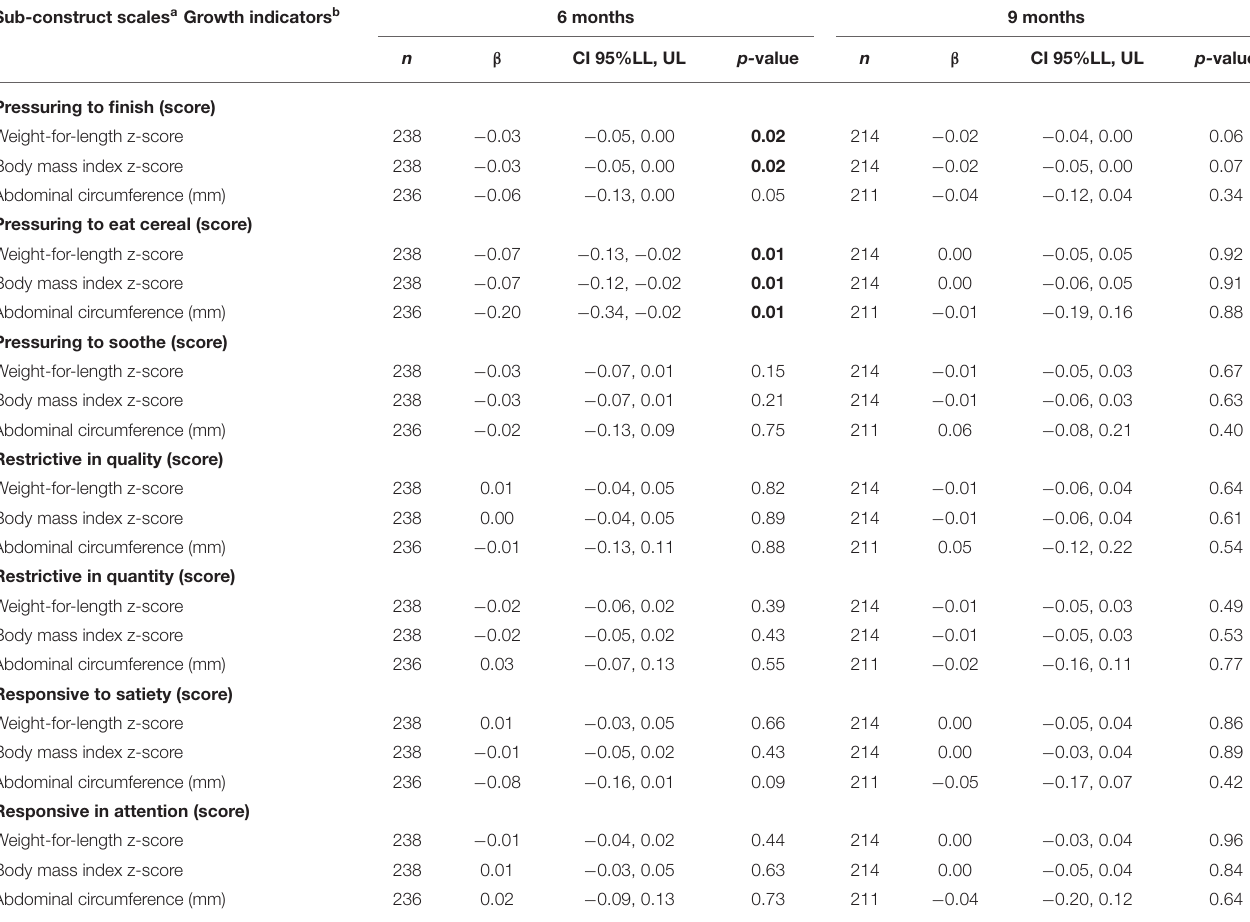
TABLE 4 | Association between parental feeding style sub-construct scales and growth indicators. Sub-construct scales a Growth indicators